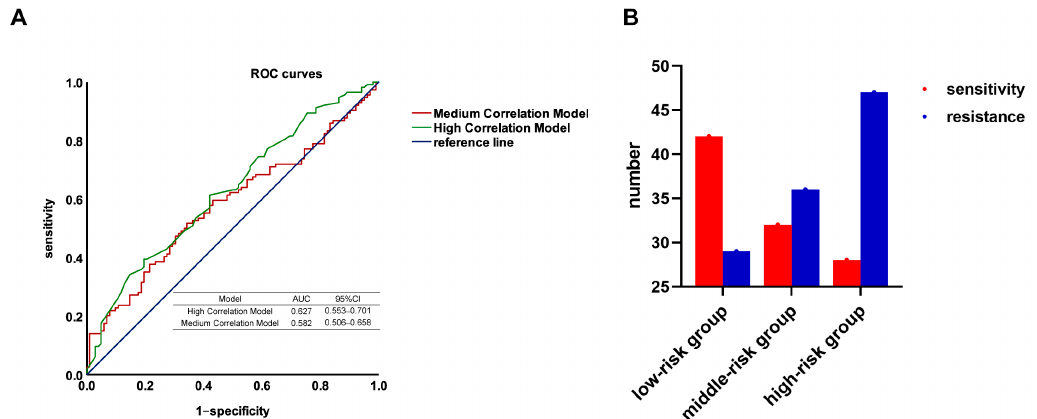
Figure 5. The performance of the platinum–based chemotherapy response genetic model in the validation cohort. ( A ) AUCs of ROC curve of models established by PRS; ( B ) Using PRS to group the validation cohort. Based on the scores, the samples are divided into three groups: low, medium, and high. The number of sensitive (red) and resistant (blue) patients in each group is shown.